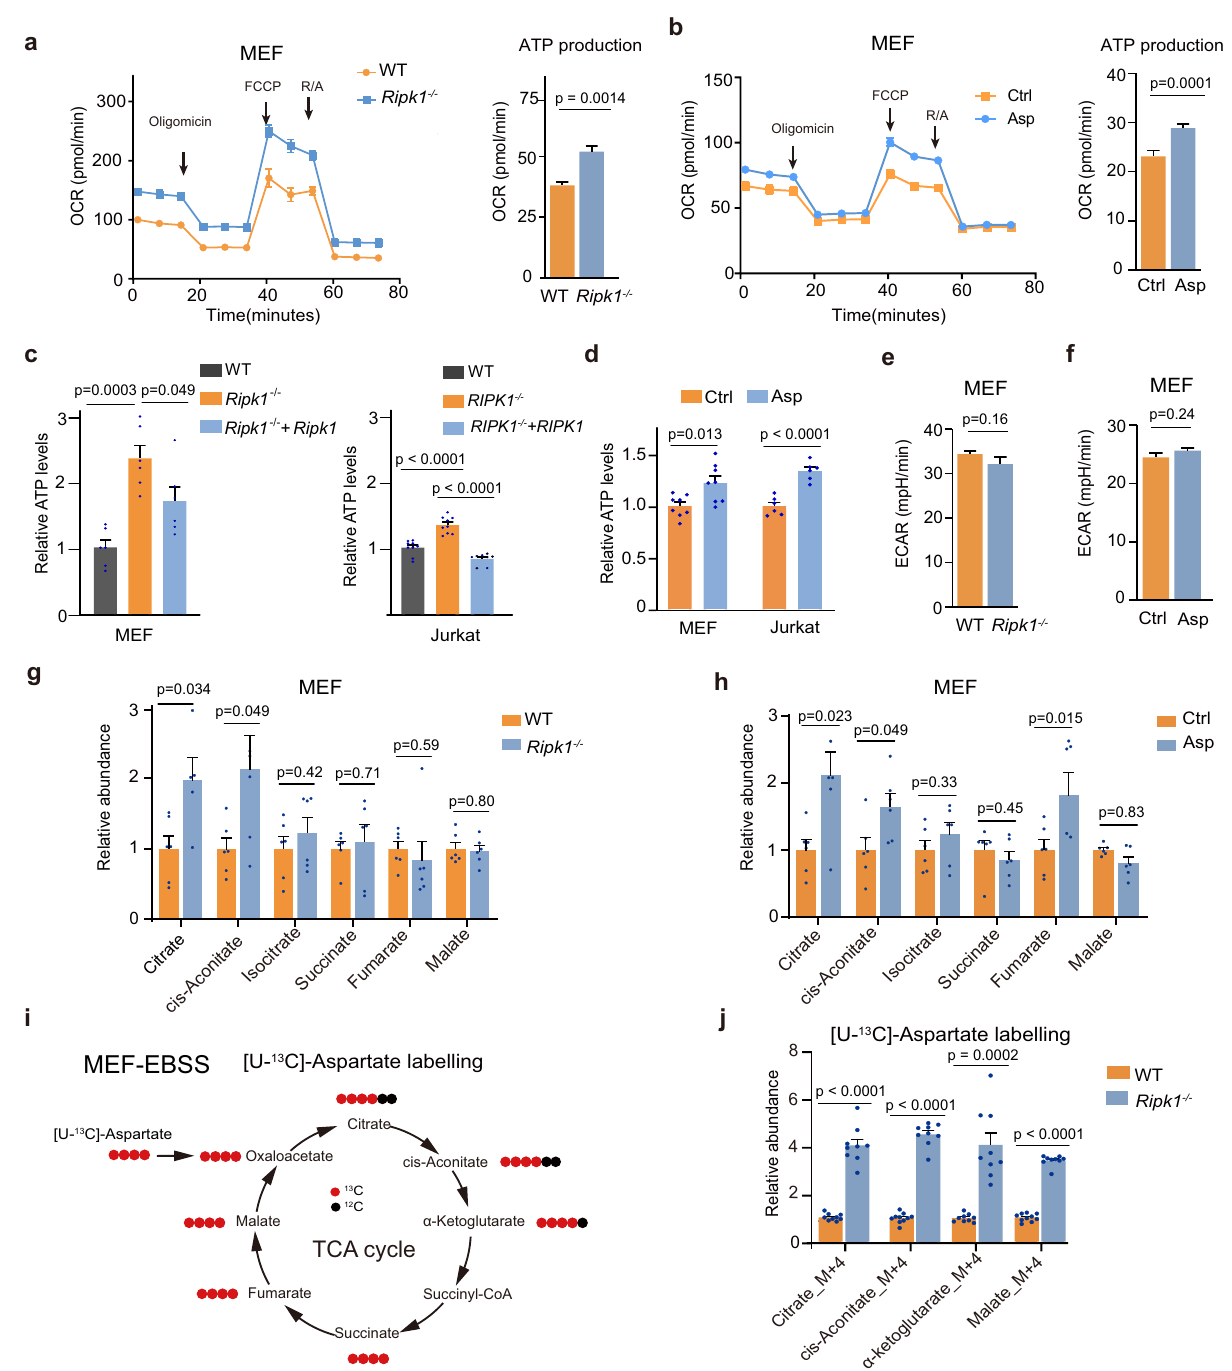
treatment, Ripk1 − / − MEFs showed higher cell viability than untreated cells under starvation conditions (Fig. 8a, b). SP1 overexpression, which upregulated the expression of aspartate catabolism genes and decreased aspartate in Ripk1 − / − cells (Fig. 8c), rescued the viability of RIPK1 − / − HEK293T cells under starvation conditions (Fig. 8d, e). Taken together, the results demonstrated that aspartate catabolism represents the underlying mechanism by which RIPK1 regulates starvation resistance (Fig.